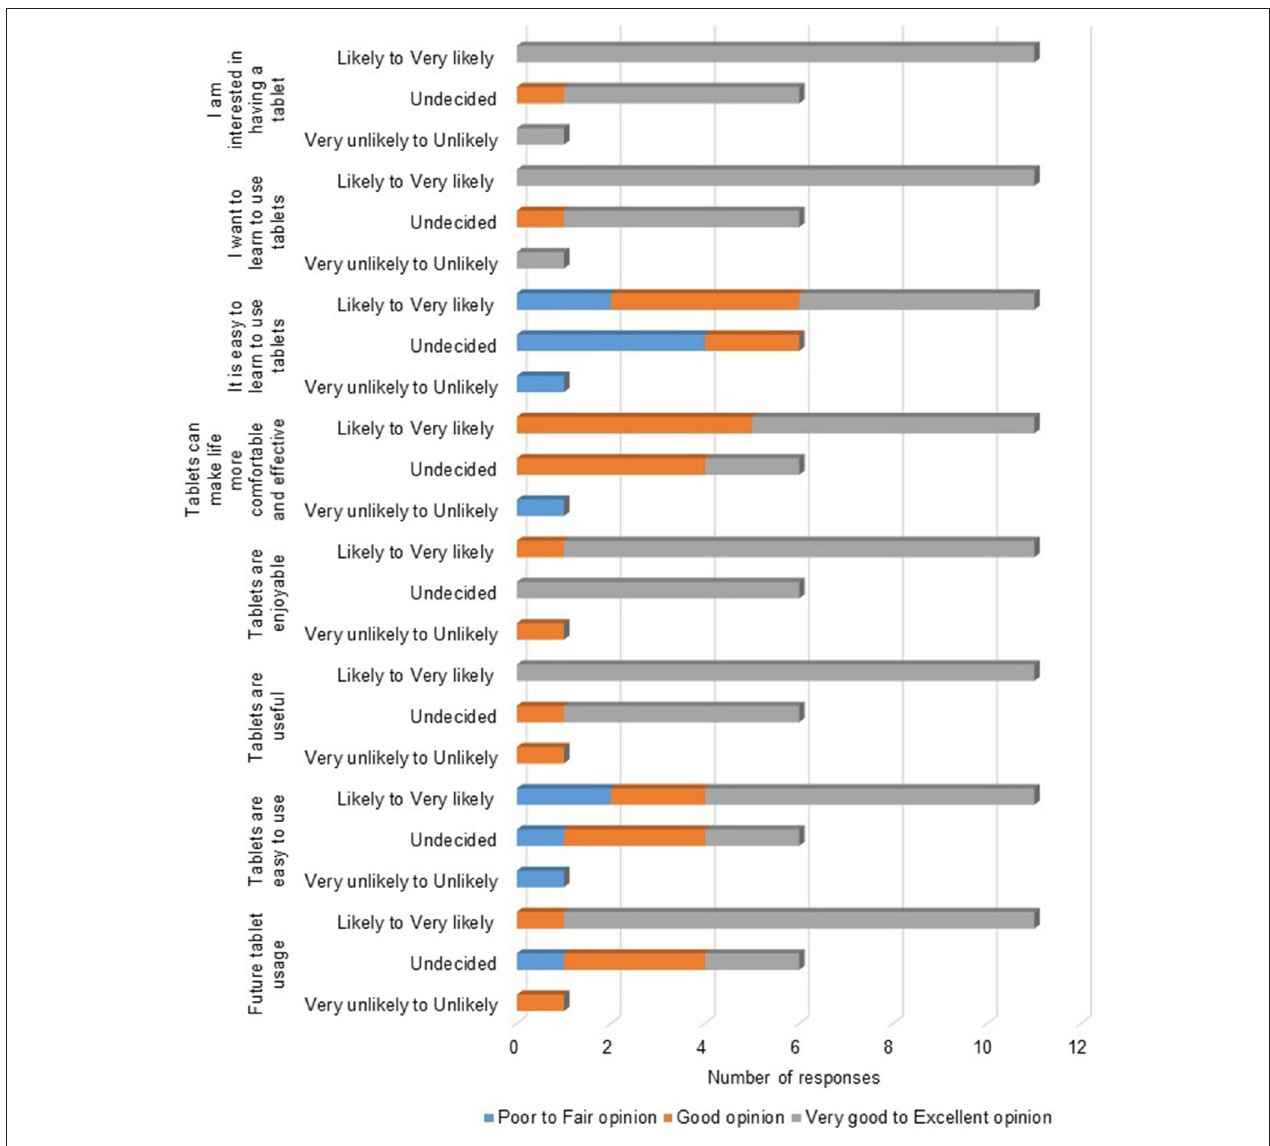
FIGURE 1 | Cross-classification of overall tablet